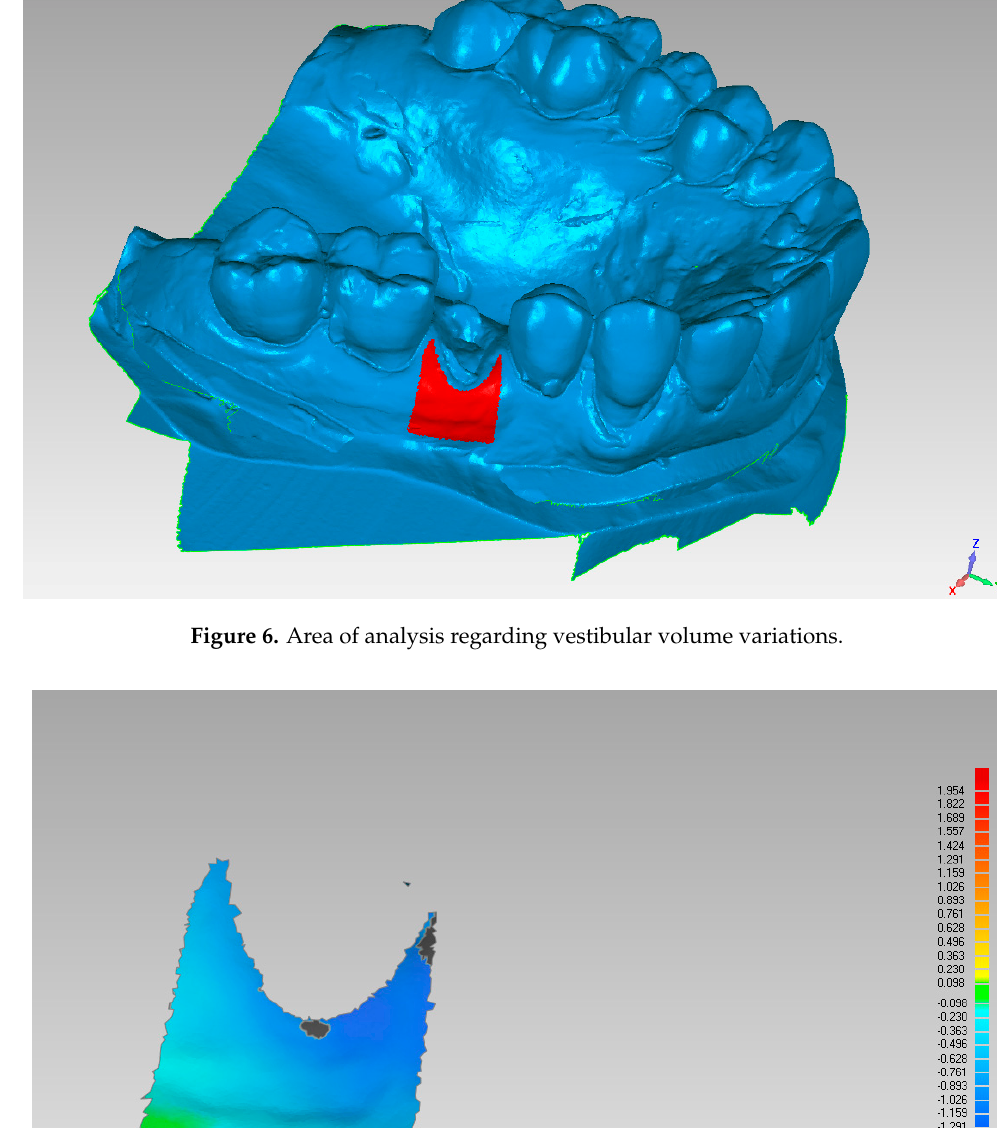
Figure 5. Analysis of palatal variation in the pre-implant placement model compared to pre-ex- traction model.